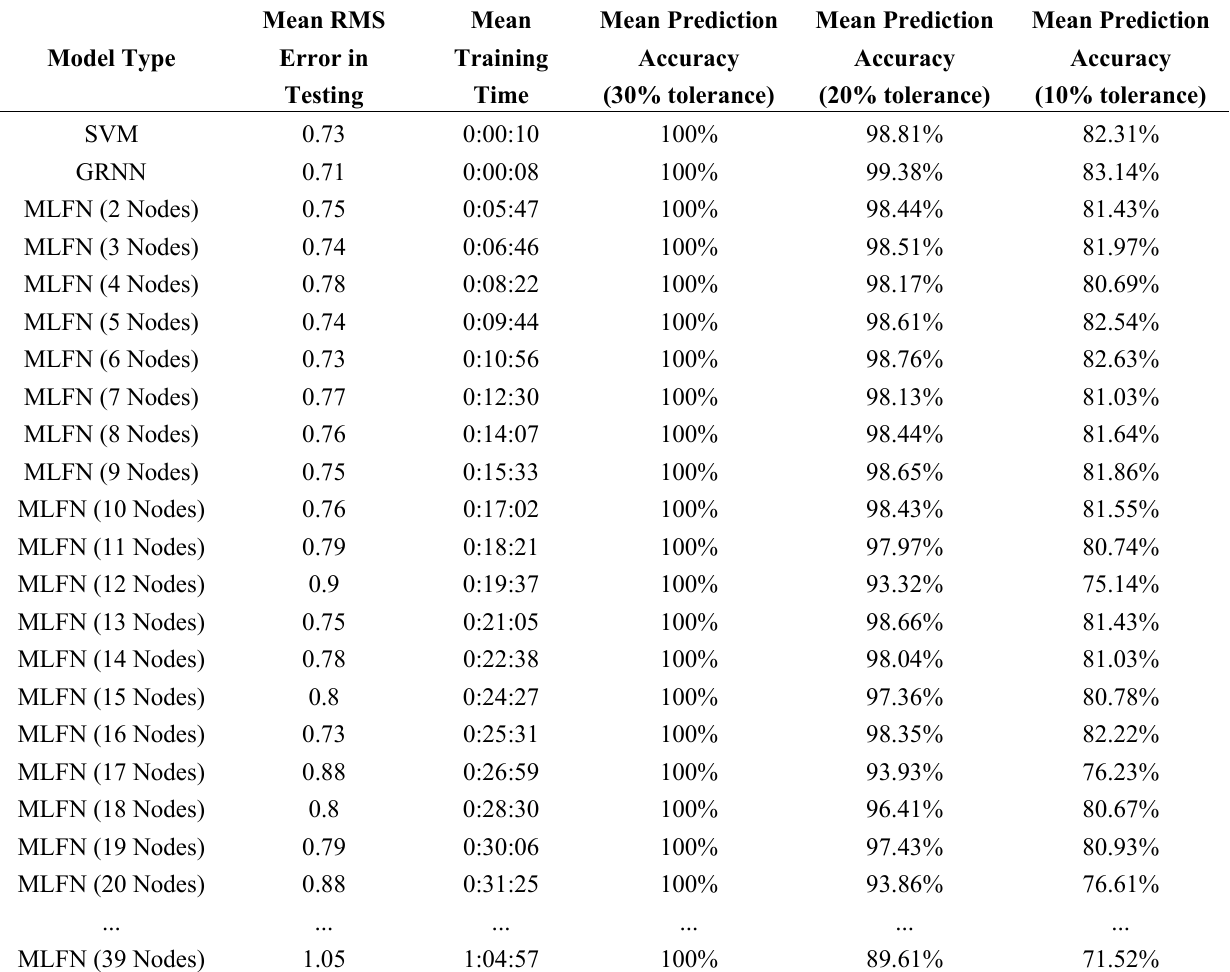
Table 4. Results of prediction models for heat loss